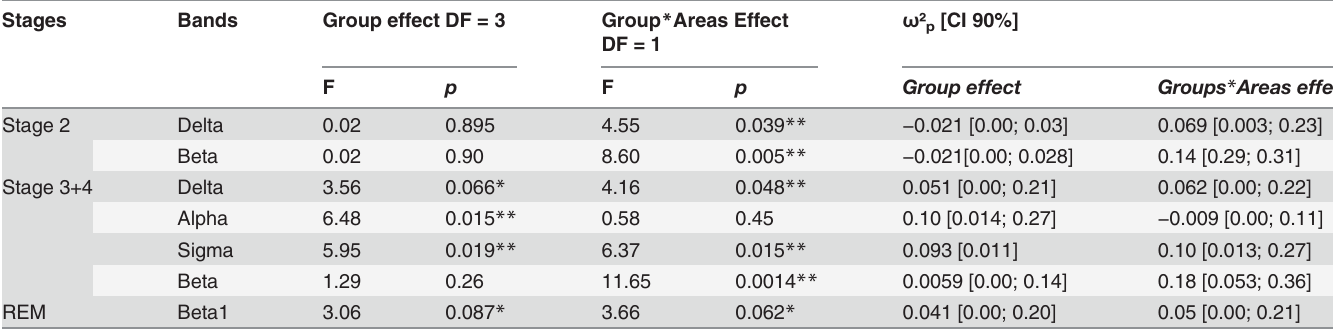
Table 3. Signi fi cant results of the power spectral